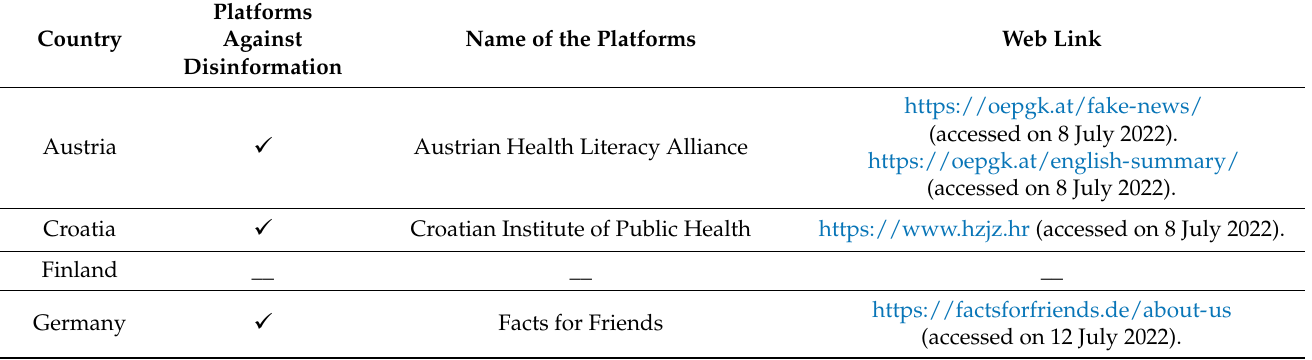
Table 4. Online platforms fighting COVID-19 related disinformation.